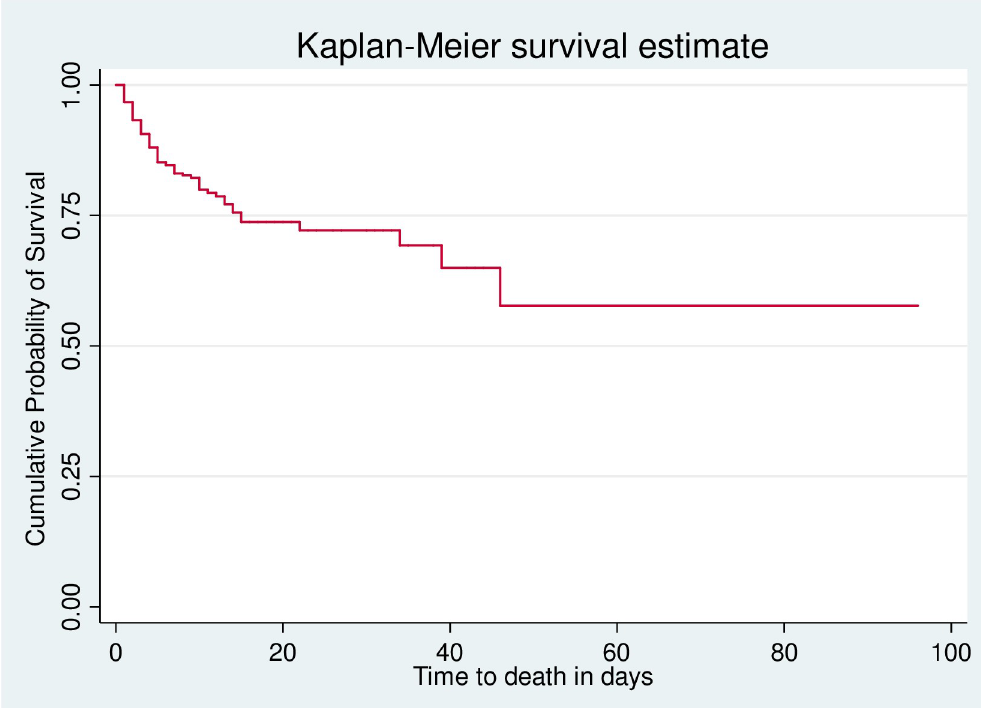
Fig 1. Overall Kaplan-Meier estimation of their survival of admitted head injury patients in HUCSH, Hawassa, Southern Ethiopia; from July 2017 to July 2019.